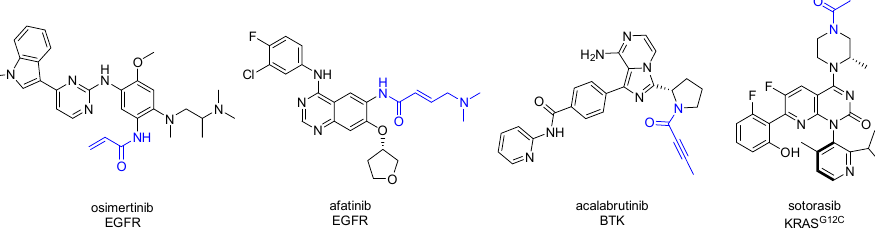
Figure 1. Representative examples of FDA approved covalent inhibitors Osimertinib (2015), afatinib (2013), acalabrutinib (2017), and sotorasib (2021) alongside their targeted proteins. Reactive groups are highlighted in blue